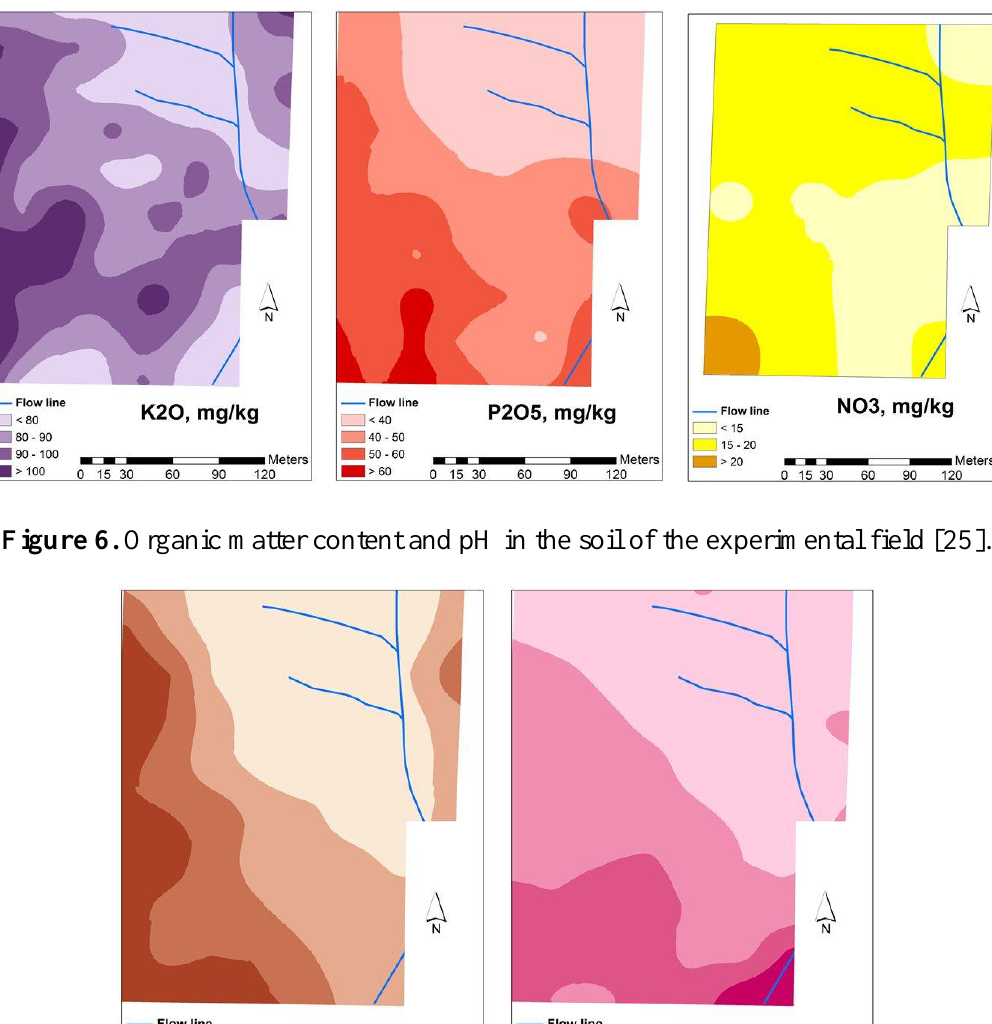
O, P O and NO ) in the soil of the experimental field [25]. 2 2 5 3